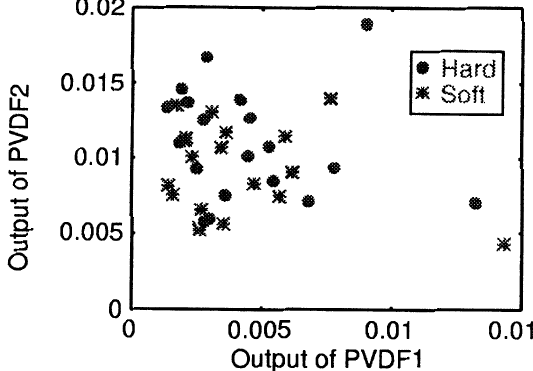
Fig. 15. Plot of indexes I 1 and I 2 calculated by eq.(1) (clinical test in rectal palpation). the figure indicates the patients whose prostate